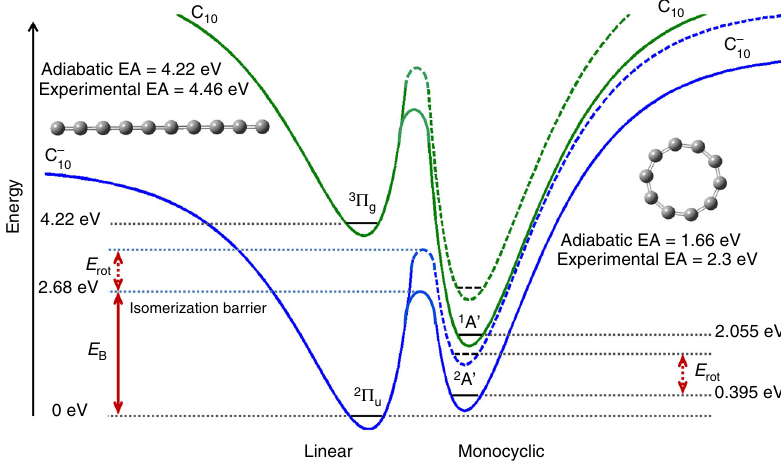
. The ground states of linear and monocyclic C (cid:1) are shown by the solid lines. The energy shift Fig. 3 Schematic of the DFT potential energy surfaces of C (cid:1) 10 10 due to rotational energy of the linear C (cid:1) is set to 0 eV in the energy scale. The energy levels for monocyclic C (cid:1) are shown relative to the linear C (cid:1) energy 10 10 10 scale. Due to conservation of rotational angular momentum during isomerization from linear to monocyclic C (cid:1) , the isomerization barrier as well as the 10 energy levels of monocyclic C (cid:1) will be shifted with respect to linear C (cid:1) (shown by dashed lines). E rot is the amount by which this shift occurs and is the 10 10 difference of rotational energies between the linear and monocyclic C (cid:1) with a particular rotational quantum number. The probability that the system is in a 10 certain rotational state (with a particular quantum number) depends on the rotational temperature of the cluster at the time of laser